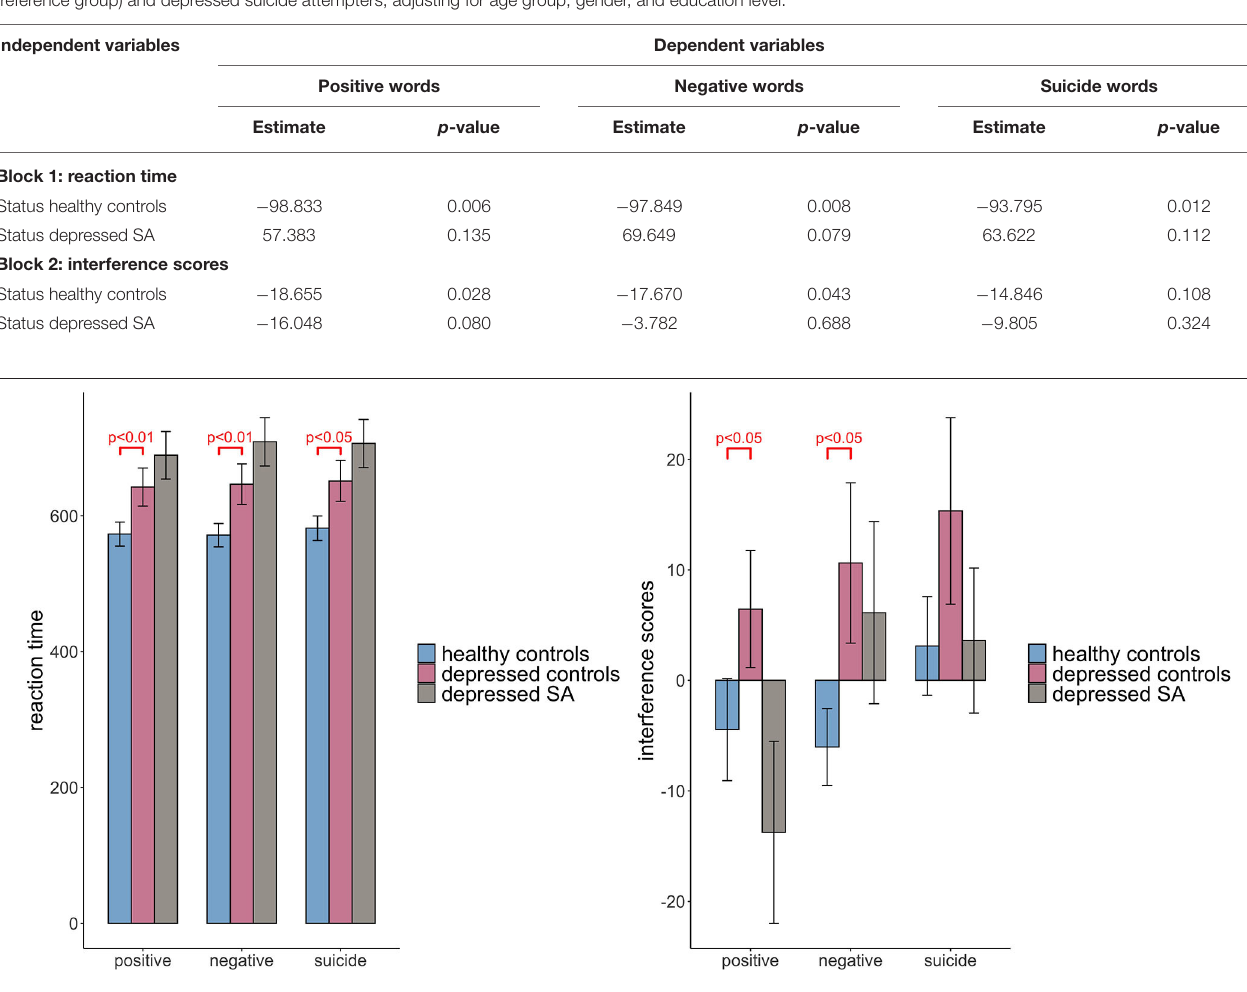
FIGURE 3 | Comparison of Stroop task reaction time and interference scores among three groups: healthy controls, depressed controls and depressed suicide attempters. Raw scores before covariate adjustment are presented, and error bars represent standard error of the mean. Significant results are obtained from regression models adjusting for age, gender and education